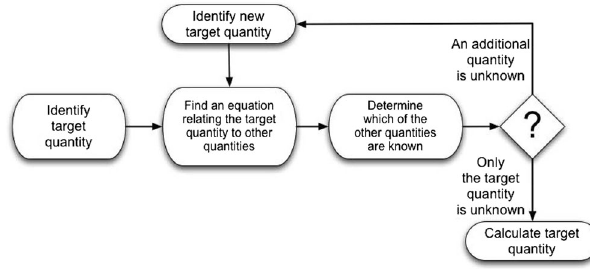
FIG. 1. Tuminaro ’ s schematic diagram for the recursive plug- and-chug epistemic game. From Ref.